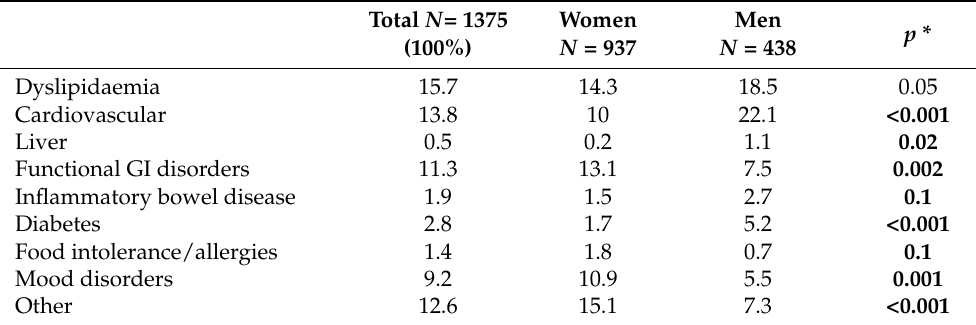
Table 2. Percentage of reported morbidities of the respondents, also according to